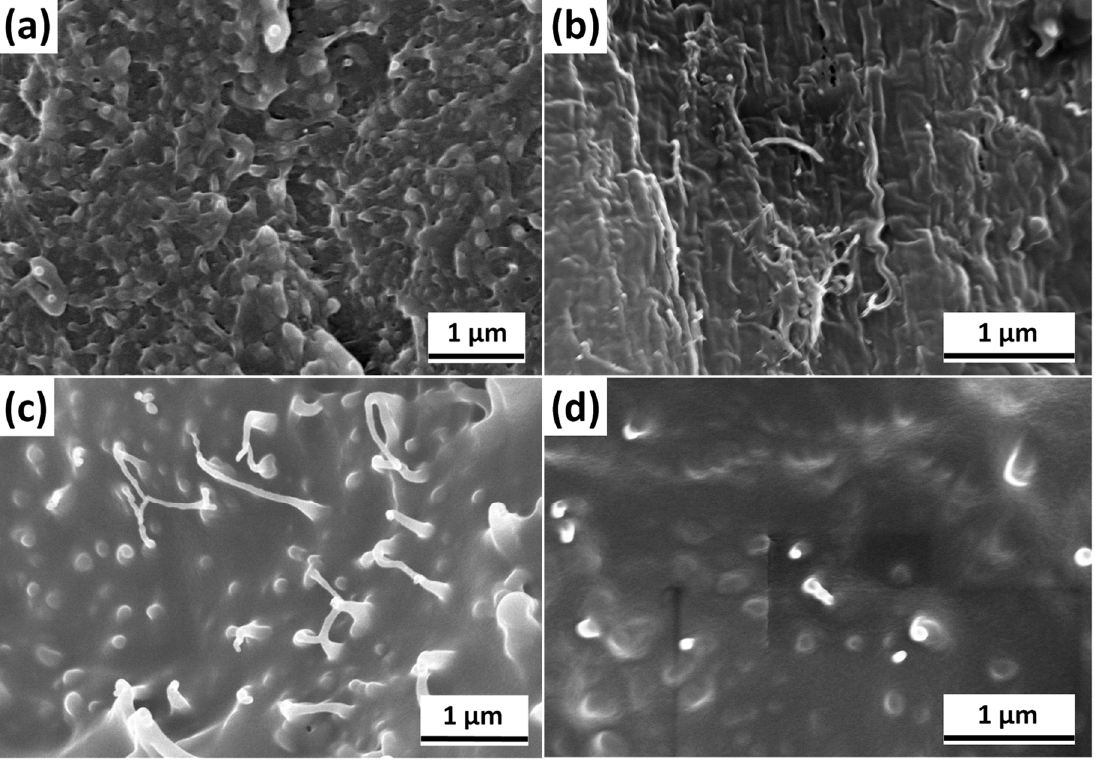
Figure 3. Scanning electron microscope (SEM) images of the composite fracture surfaces: ( a ) PBT/A-CNT; ( b ) PBT/DPP-A-CNT; ( c ) PBT/DPP(O)-A-CNT; and ( d ) PBT/DPP(O 3 )-A-CNT.